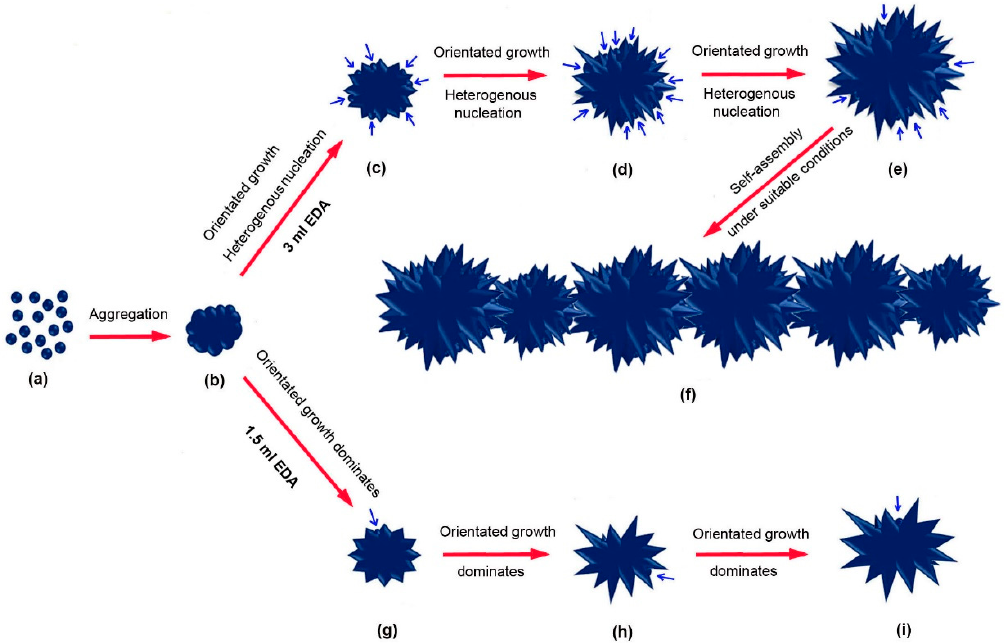
Figure 12. A scheme for the growth mechanism of Ni nano-micro structures: ( a ) Ni nanocrystals; ( b ) aggregation of Ni nanocrystals; ( c ) small-sized sphere with nanohorns and new nuclei; ( d ) middle-sized microspheres with nanohorns and new nuclei; ( e ) big-sized microspheres with nanohorns and new nuclei; ( f ) chain-like structure; ( g ) small-sized particle with nanohorns; ( h ) middle-sized microflower with nanohorns; and ( i ) big-sized microflower with nanohorns. New nuclei produced by heterogenous nucleation are indicated by blue arrows.